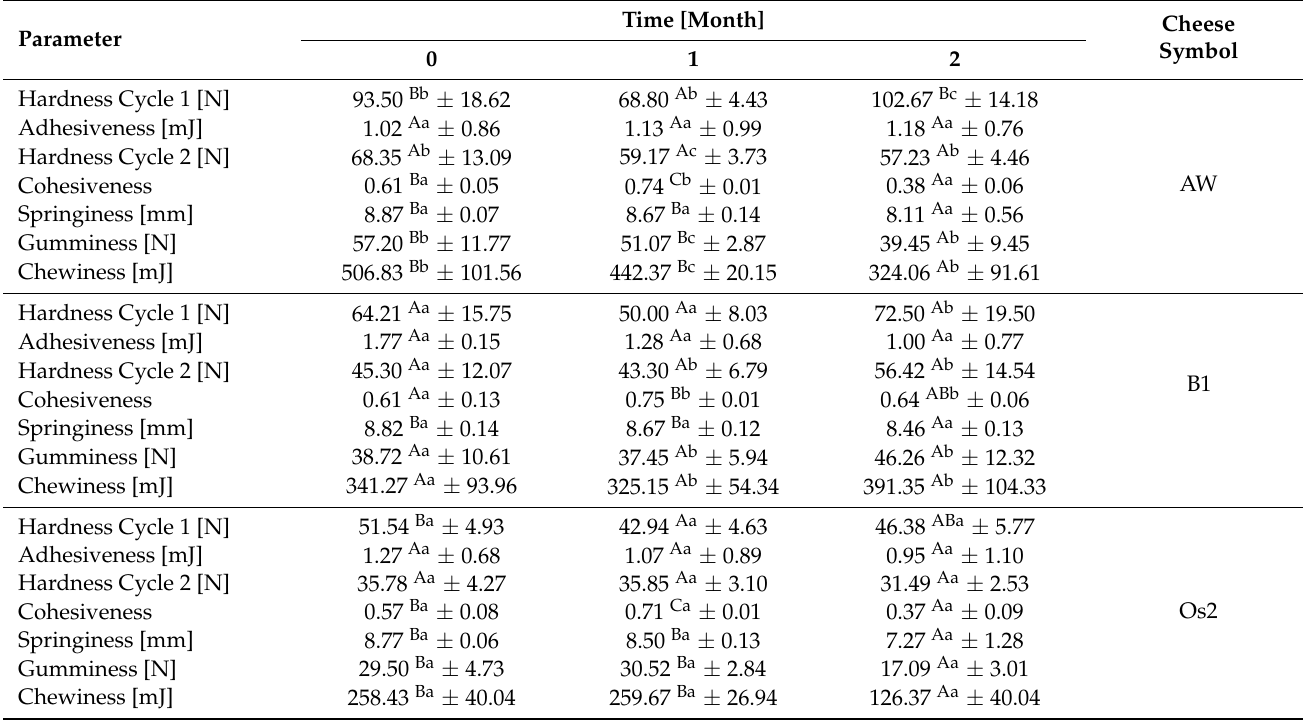
Table 7. Texture instrumental parameters of goat’s acid-rennet cheeses after production and after 1 and 2 months of